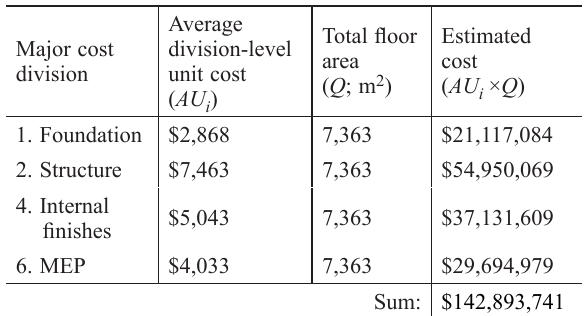
the component ratios method for project